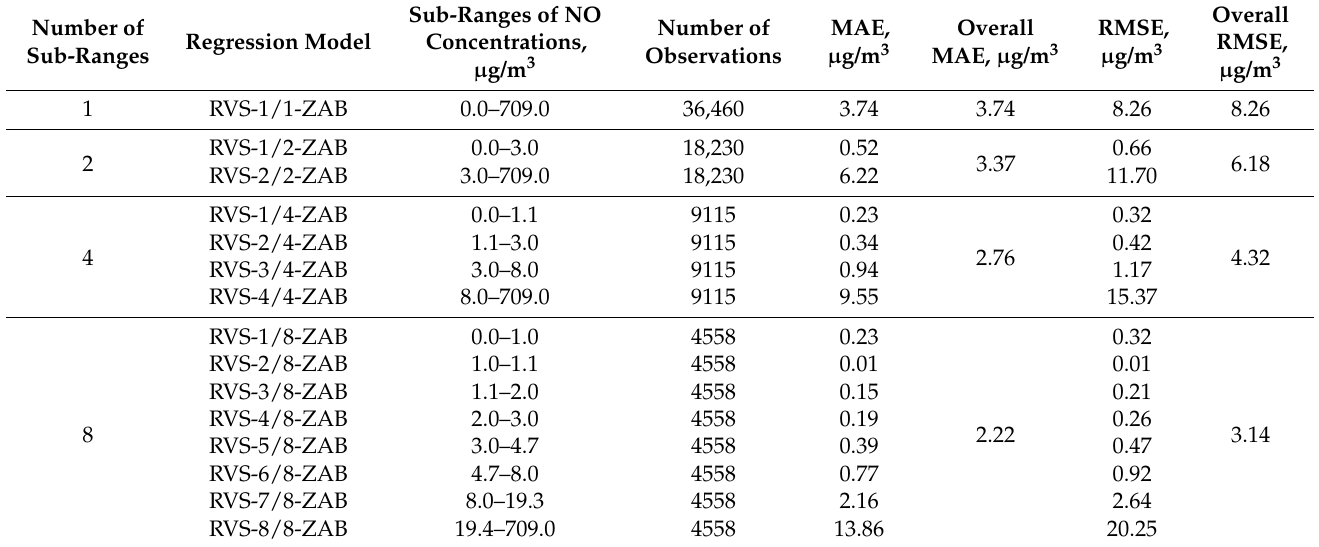
Table 9. Values of approximation errors of NO concentrations in RVS models, Zabrze 2011–2016.